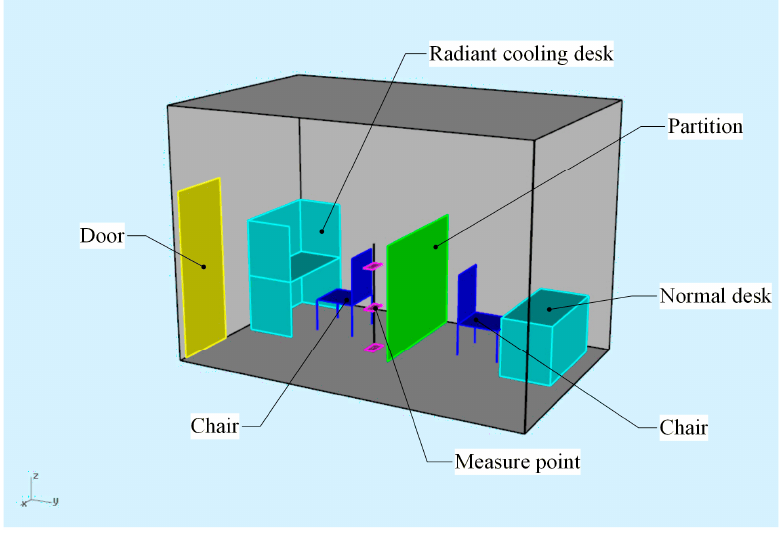
Figure 1. The office room for field experiments.